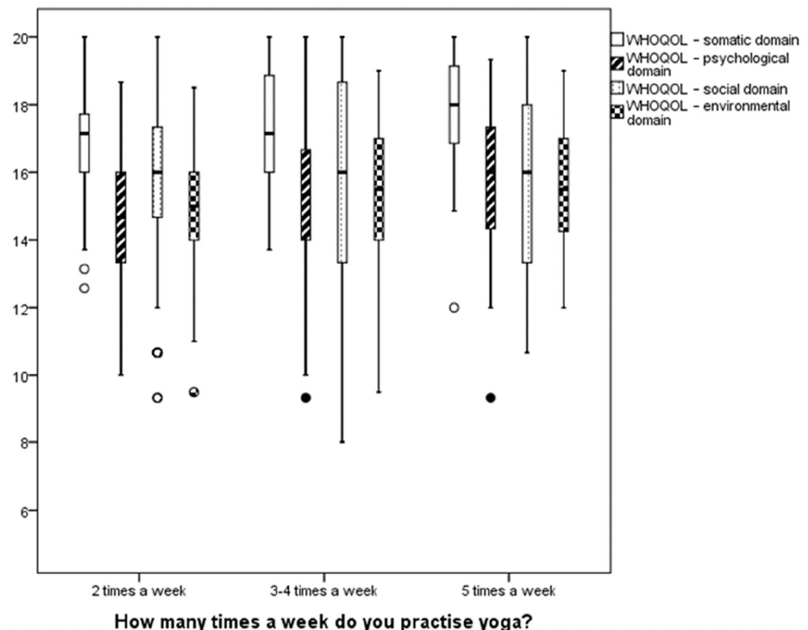
Figure 4. Graphic representation of quality-of-life domains of groups with varying frequency of yoga practice. Annotation . Lower boundary of the box—lower quartile; upper boundary of the box—upper quartile; line inside the box—median; o—observations from 1.5 to 3 quarter spacing from the box;